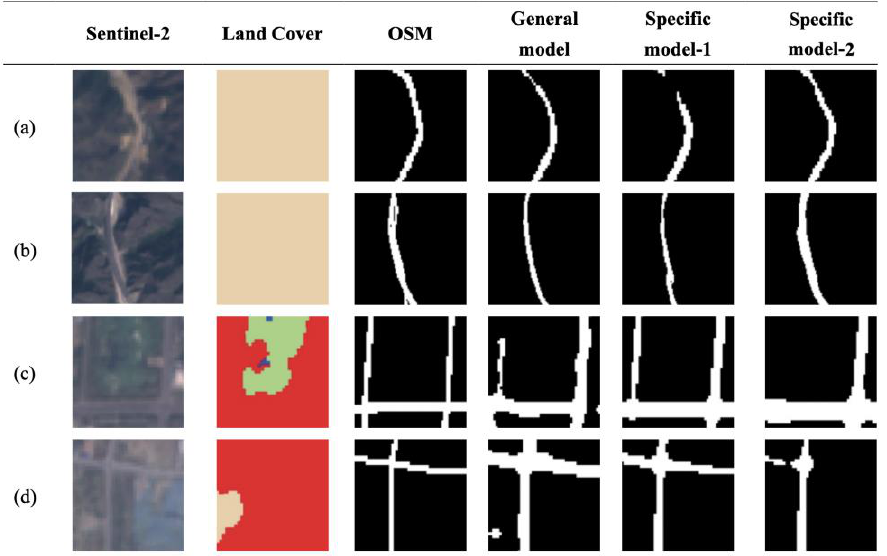
Figure 6. Qualitative comparisons of road extraction by different sub-modules. ( a , b ) Scrub/shrubs; ( c , d ) Built Area.